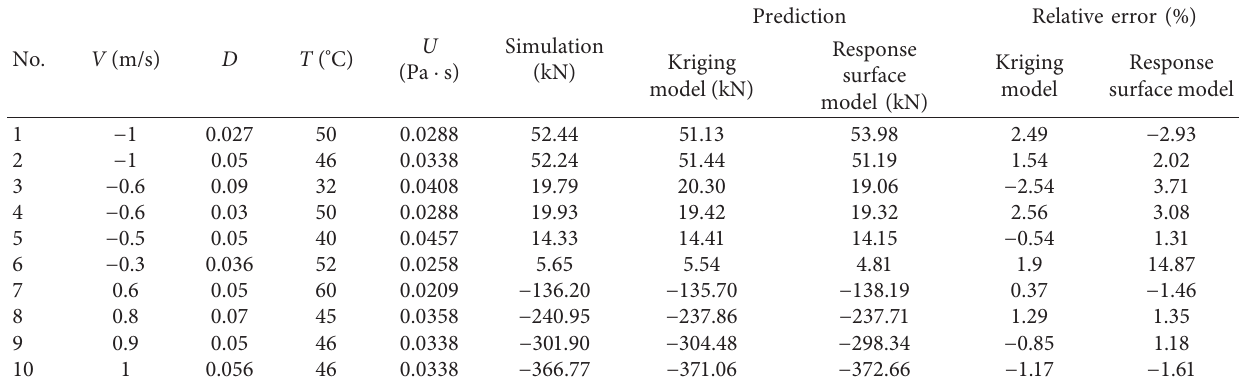
Table 7: Damping force